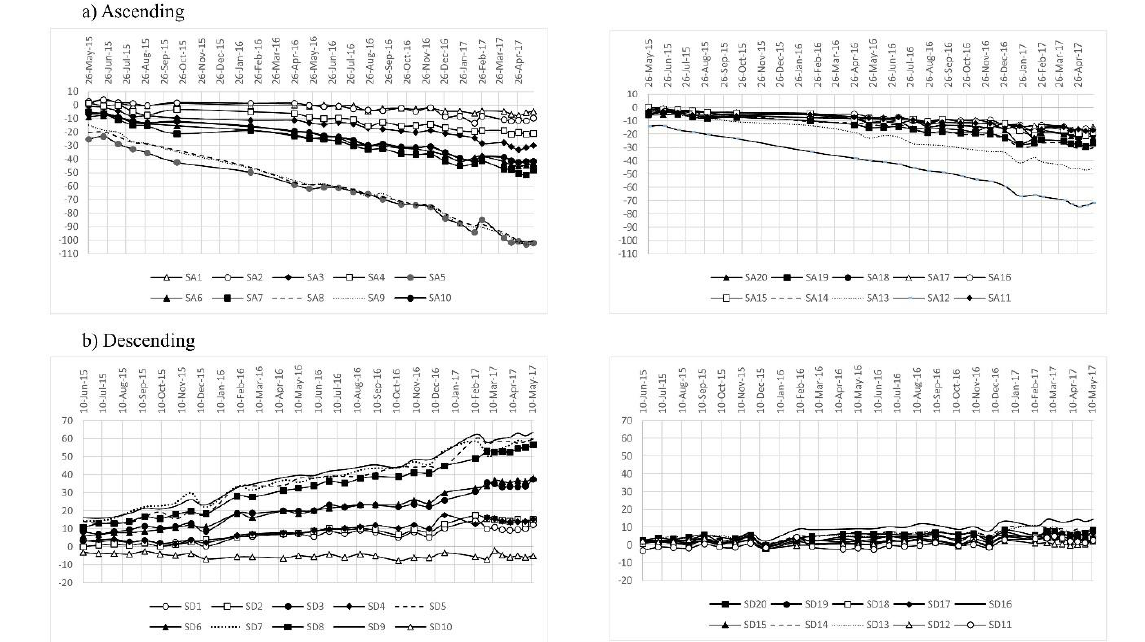
Figure 25. Cumulative 2-year LOS displacements at the Redhill landslide by ( a ) Sentinel Ascending and ( b ) Sentinel Descending.